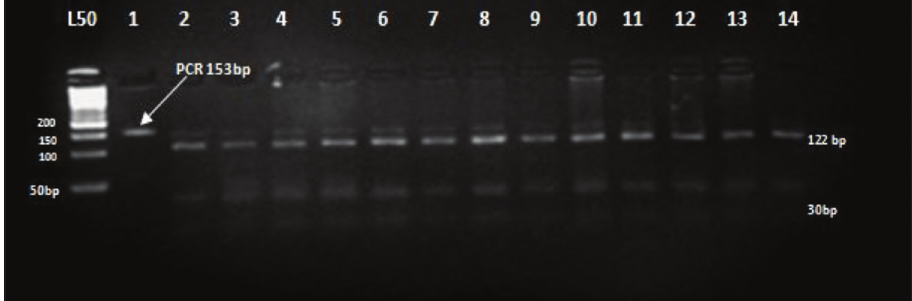
Figure-2: Agarose gel electrophoresis (4%) displaying Dde I1 restriction digest on an amplified portion of Watish BMP15- FecX B gene in exon 2. Lane: 1 polymerase chain reaction product. Lane: 2-14 representing ++ genotype (122-31 bp). Lane L: 50 bpDNA ladder.